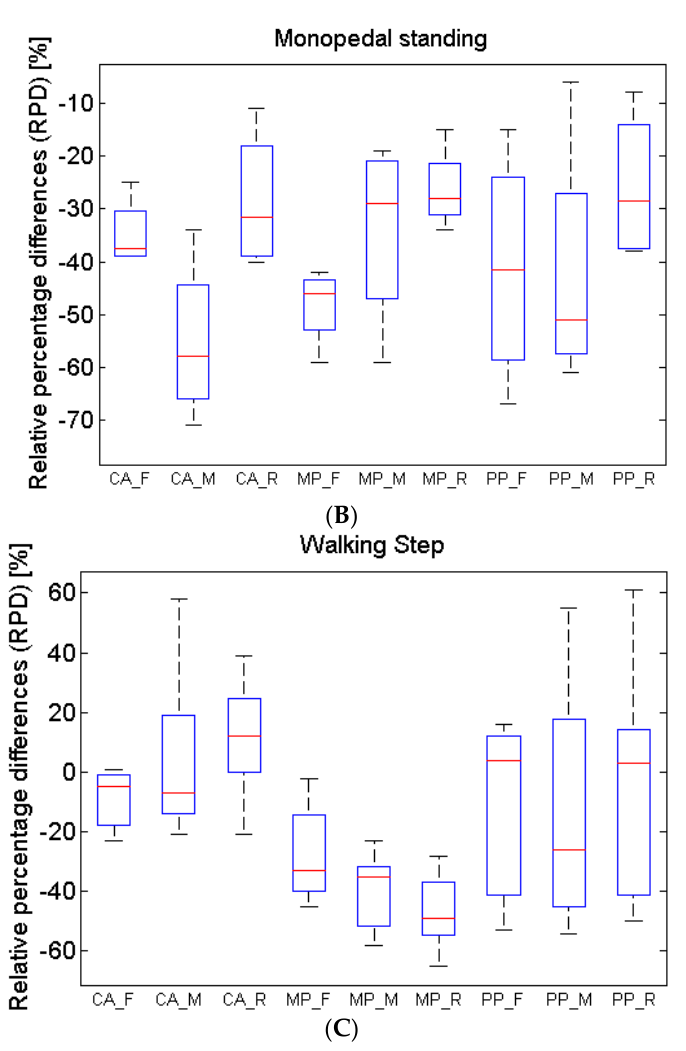
Figure 12. Boxplot of the relative percentage differences (RPD) obtained with each group of trials: bipedal standing ( A ), monopedal standing ( B ), and walking step ( C ). Individual boxplots are identified as CA-F (contact area of forefoot ), CA-M (contact area of midfoot ), CA-R (contact area of rearfoot ), MP-F (mean pressure on forefoot ), MP-M (mean pressure on midfoot ), MP-R (mean pressure on rearfoot ), PP-F (peak pressure on forefoot ), PP-M (peak pressure on midfoot ), and PP-M (peak pressure on rearfoot ).